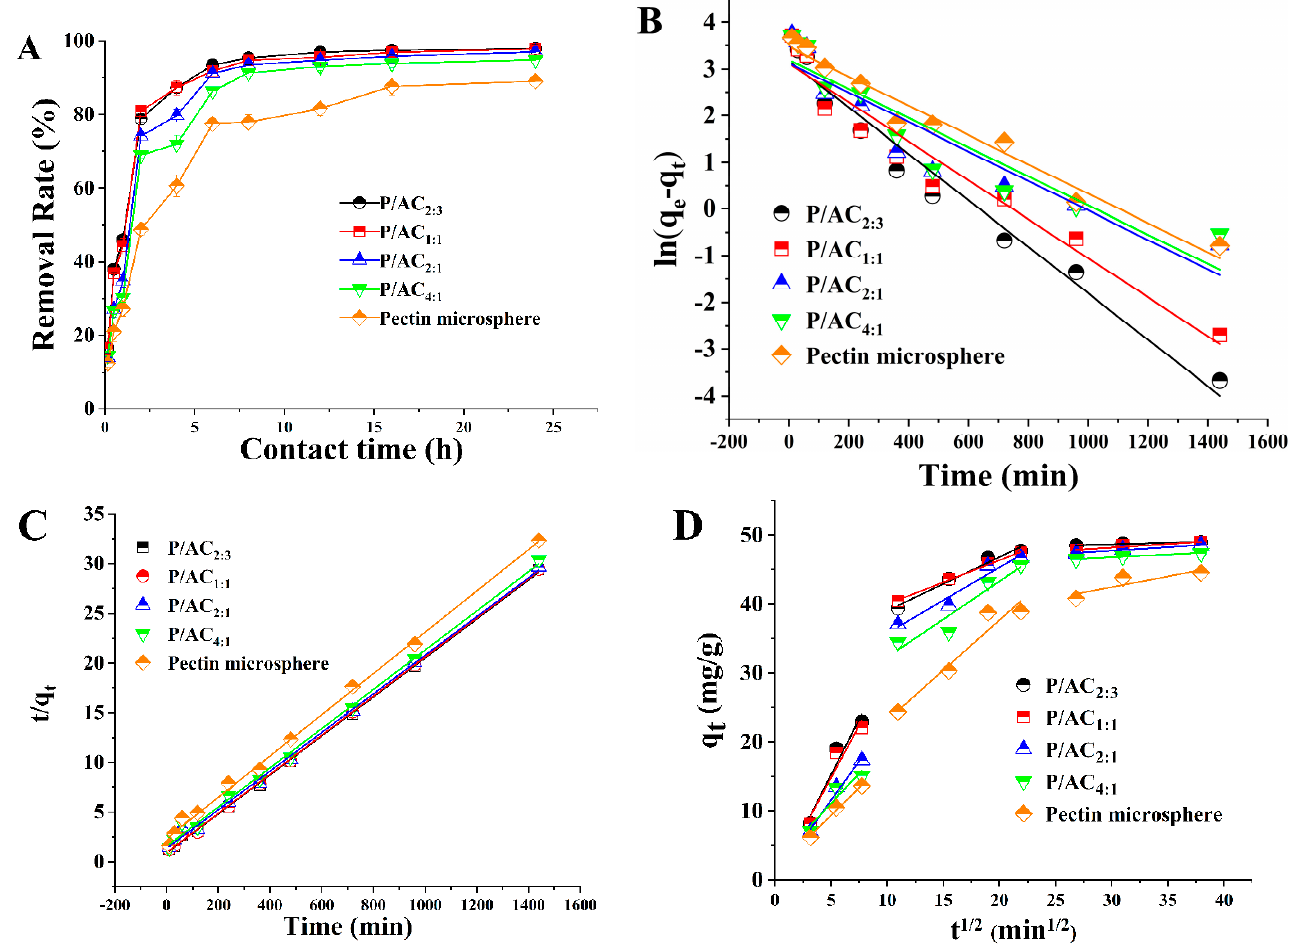
Figure 5. The effect of contact time (10, 30, 60, 240, 360, 720, 960, and 1440 min) on the removal rate of Pb 2+ adsorbed by P/ACs ( A ). The pseudo-first-order kinetic model ( B ), the pseudo-second-order kinetic model ( C ), and the intraparticle diffusion plots ( D ) for Pb 2+ adsorpted by P/ACs (adsorbent dosage of 1.0 g/L, initial Pb 2+ concentration of 50 mg/L, temperature of 298 K, pH of 5.0).